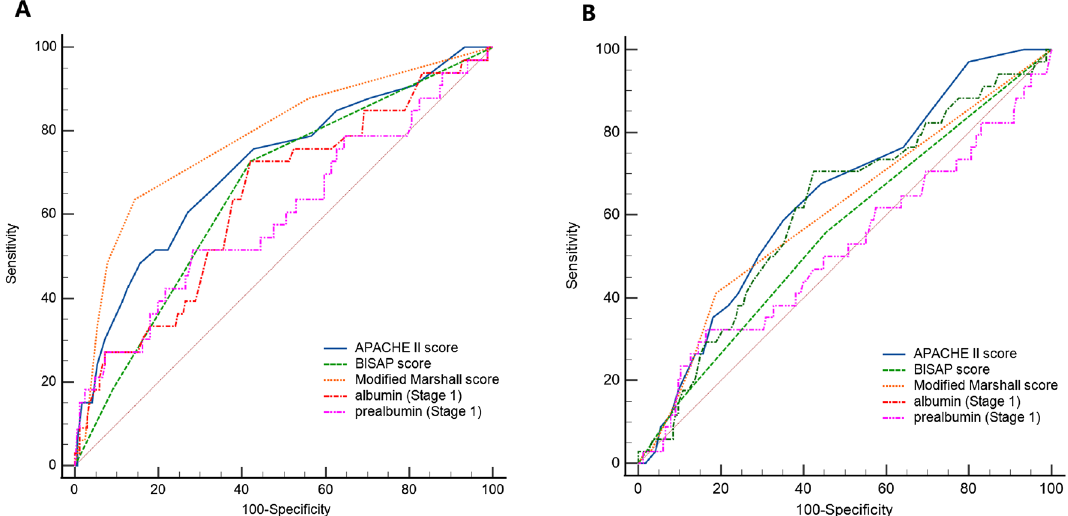
Figure 3. ROC curves of the APACHE II score, BISAP score, Modified Marshall score, first stage albumin and prealbumin for prognosis. ( A ) The comparison of ROC curves for nonsurvival. ( B ) The comparison of ROC curves for laparotomy.